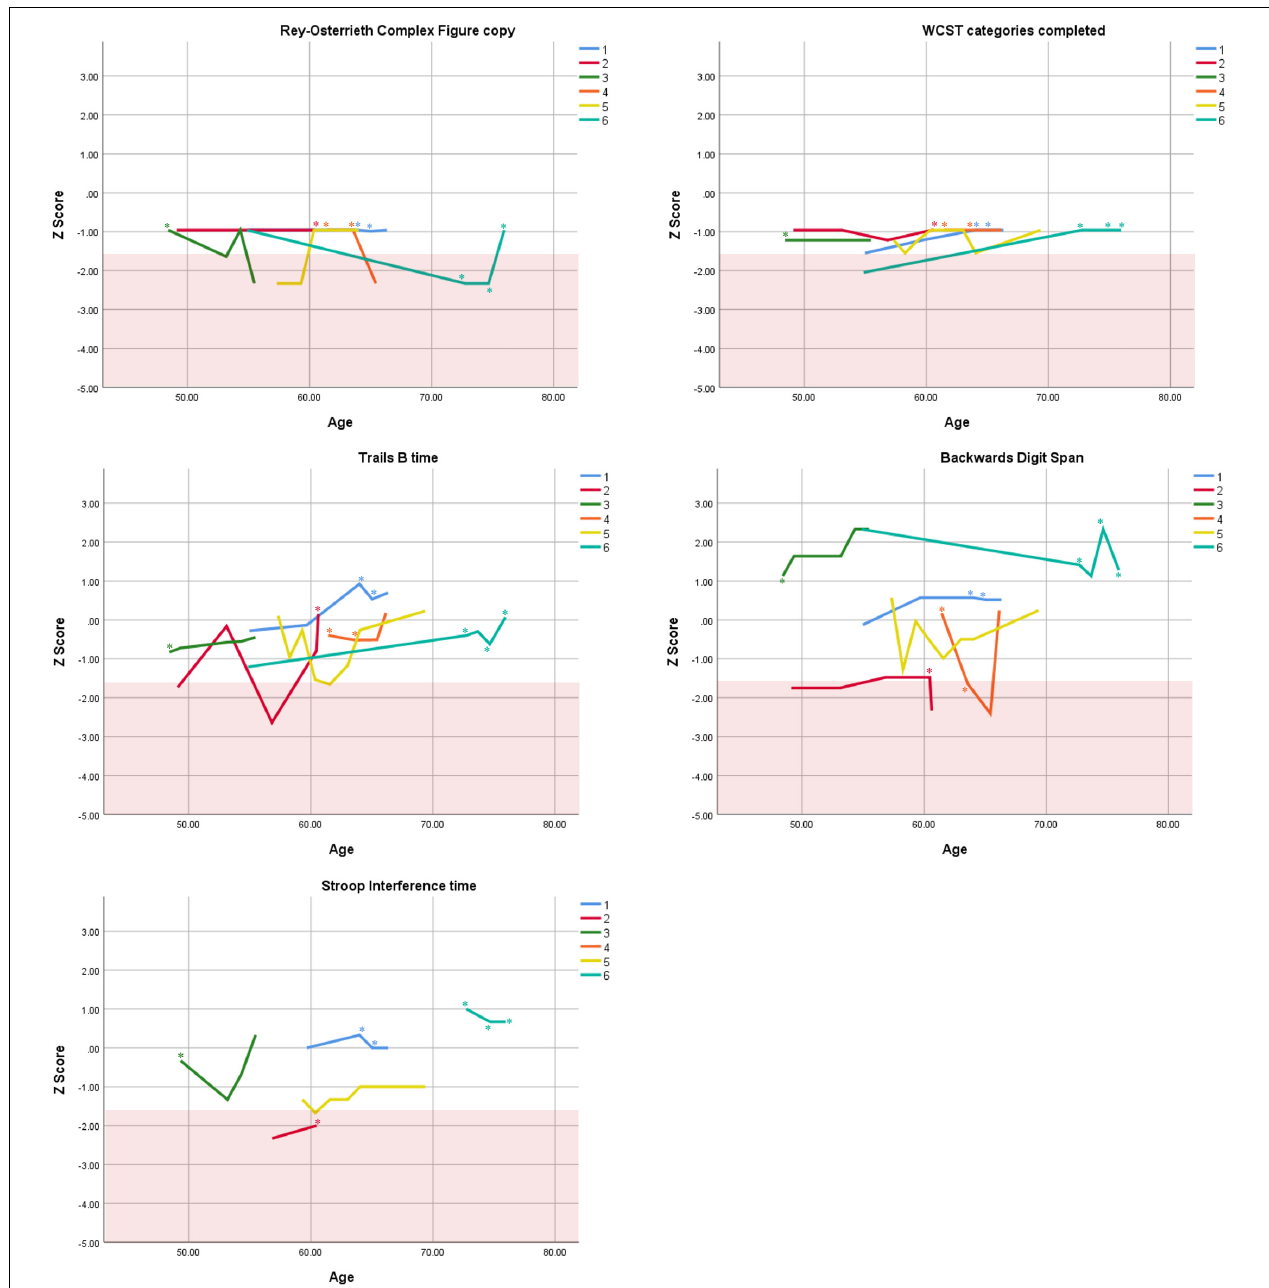
FIGURE 5 | Individual longitudinal performance on measures of executive functioning. Shaded red area represents impaired performance ( Z < –1.5). WCST = Wisconsin Card Sorting Test. *Denotes clinically significant depressive symptoms at that visit (30-item GDS ≥ 10 or BDI-II ≥